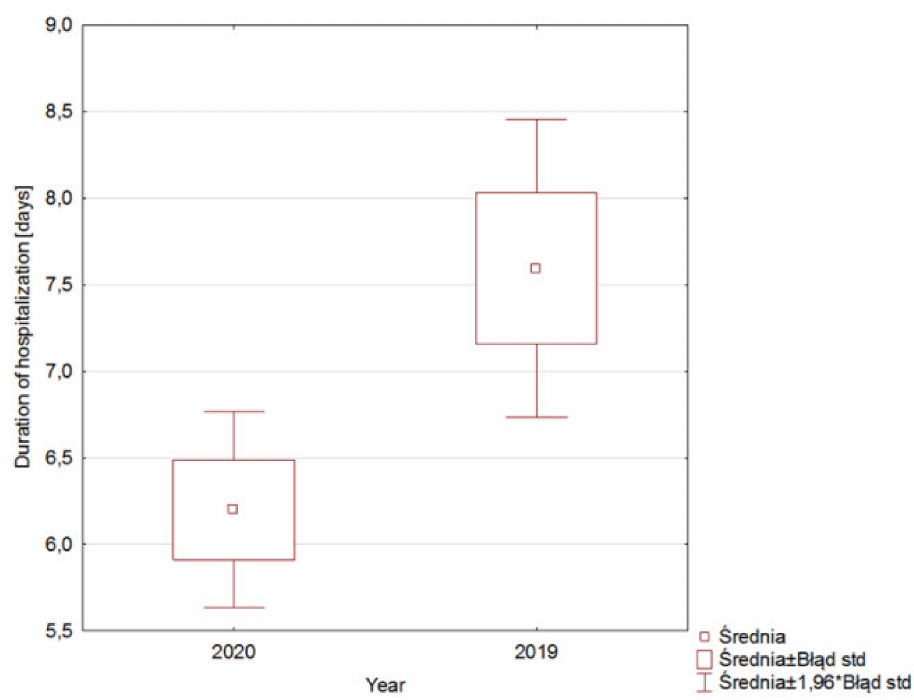
Figure 3. Duration of